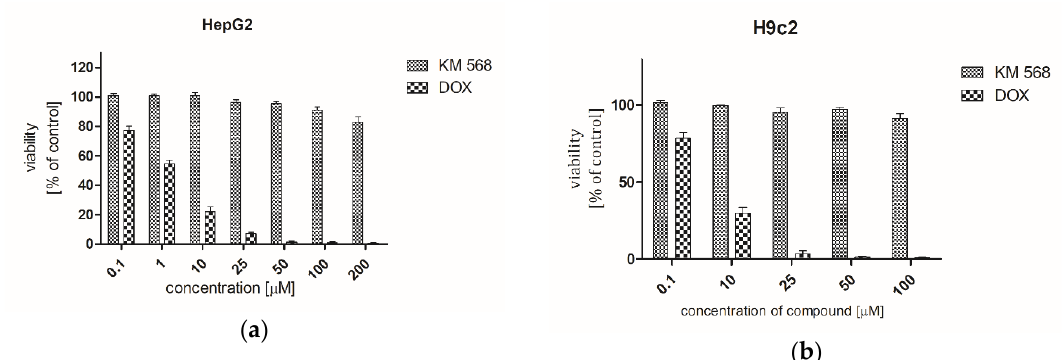
Figure 7. Results of cytotoxicity evaluation of compound KM-568 and doxorubicin (DOX) in ( a ) HepG2 and ( b ) H9c2 cell lines in an MTT assay. Results were presented as mean ± SD from three samples.